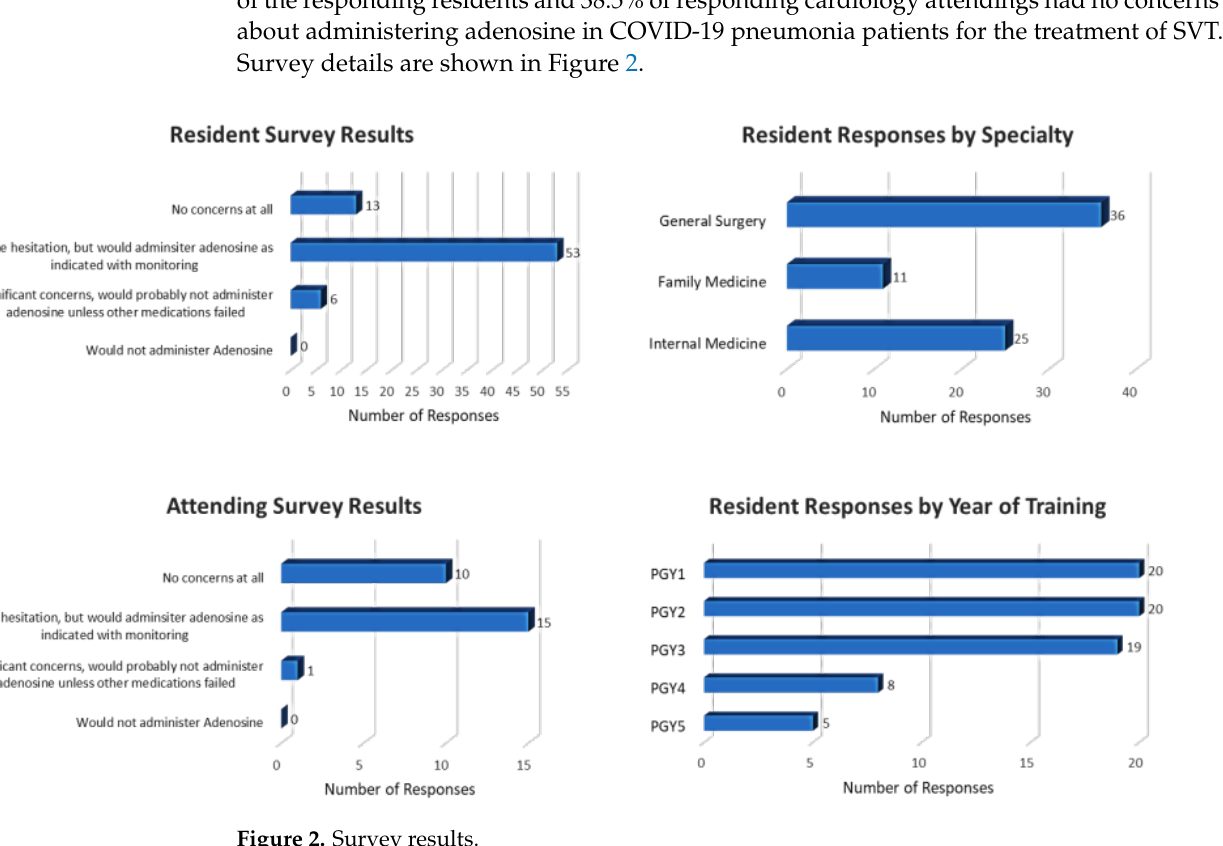
Table 1. Baseline characteristics of total population in this study.